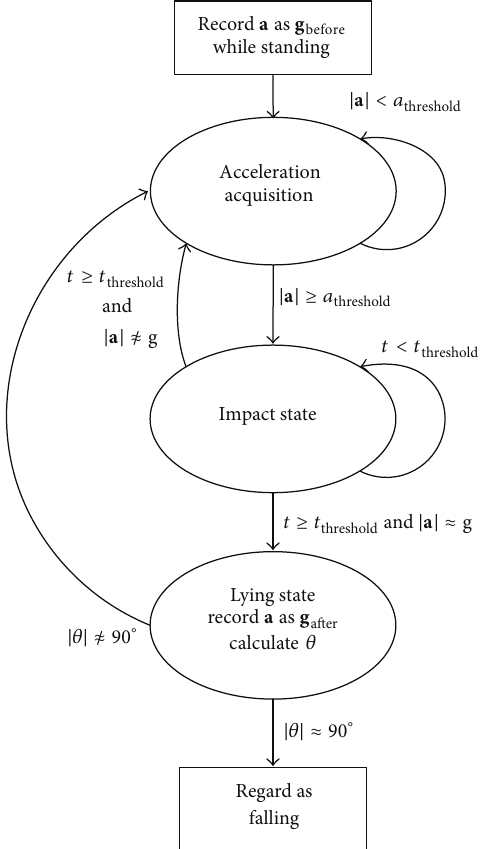
Figure 5: Fall detection algorithm state machine.